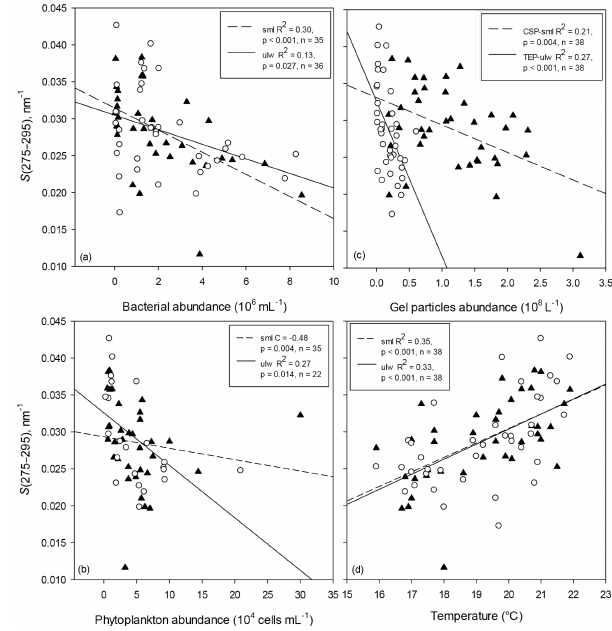
Figure 9. (a) Linear regression between bacterial abundance [10 6 cellsmL − 1 ] and spectral slope S (275–295) [nm − 1 ] in SML and ULW. (b) Linear regression (ULW) and Spearman rank order correlation (SML) between phytoplankton abundance [10 4 cellsmL − 1 ] and spectral slope S (275–295) [nm − 1 ]. (c) Linear regression between CSP abundance [10 8 particlesL − 1 ] and spectral slope S (275–295) [nm − 1 ] in the SML and between TEP abundance [10 8 particlesL − 1 ] and spectral slope S (275–295) [nm − 1 ] in the ULW. (d) Linear regression between temperature [ ◦ C] and S (275– 295) [nm − 1 ] in SML and ULW. Black triangles: SML, open dots: